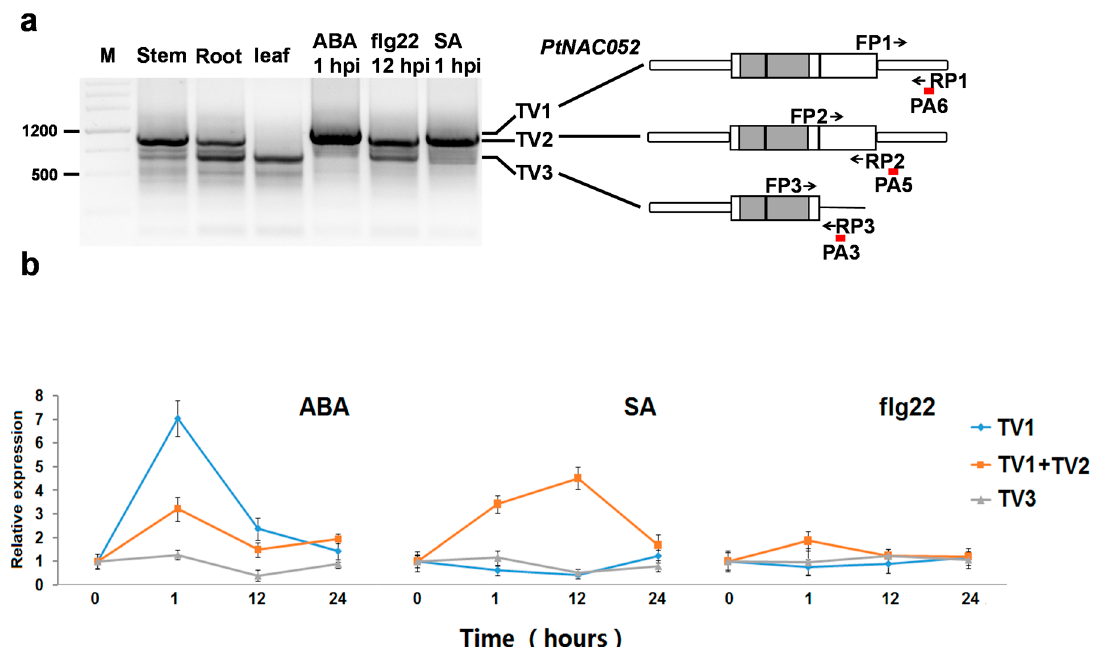
Figure 5. Alternative polyadenylation (APA) transcripts of PtNAC052 differentially regulated across tissues and in response to plant hormones and elicitors. ( a ) Agarose gel electrophoresis of PtNAC052 3 ′ -RACE with cDNA from different tissues and treatments and principle of real-time PCR primers design for transcript variants of PtNAC052 . Arrows indicate forward primer (FP) and reverse primer (RP). Due to the overlapping of TV1 and TV2, FP2 and RP2 of PtNAC052 were designed to amplify TV1 and TV2 simultaneously. Rectangle: annotated exon; round rectangle: 5 ′ -UTR or 3 ′ -UTR; straight line: annotated intron; grey rectangle: region encoding NAC domain; short and long bold full line below indicates individual PASs and PACs, respectively; ( b ) Expression patterns of PtNAC052 TVs during response to ABA, SA and flg22. Expression levels were calculated relative to 0 hpi samples. Bars indicate mean expression ± SD (standard deviation) of three replicates. These experiments were repeated three times with similar results.